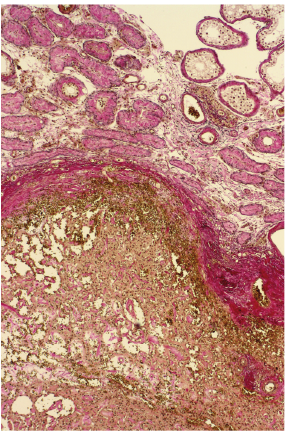
Figure4:Microscopicaspects:benignvasculartumorandtesticular parenchyma.